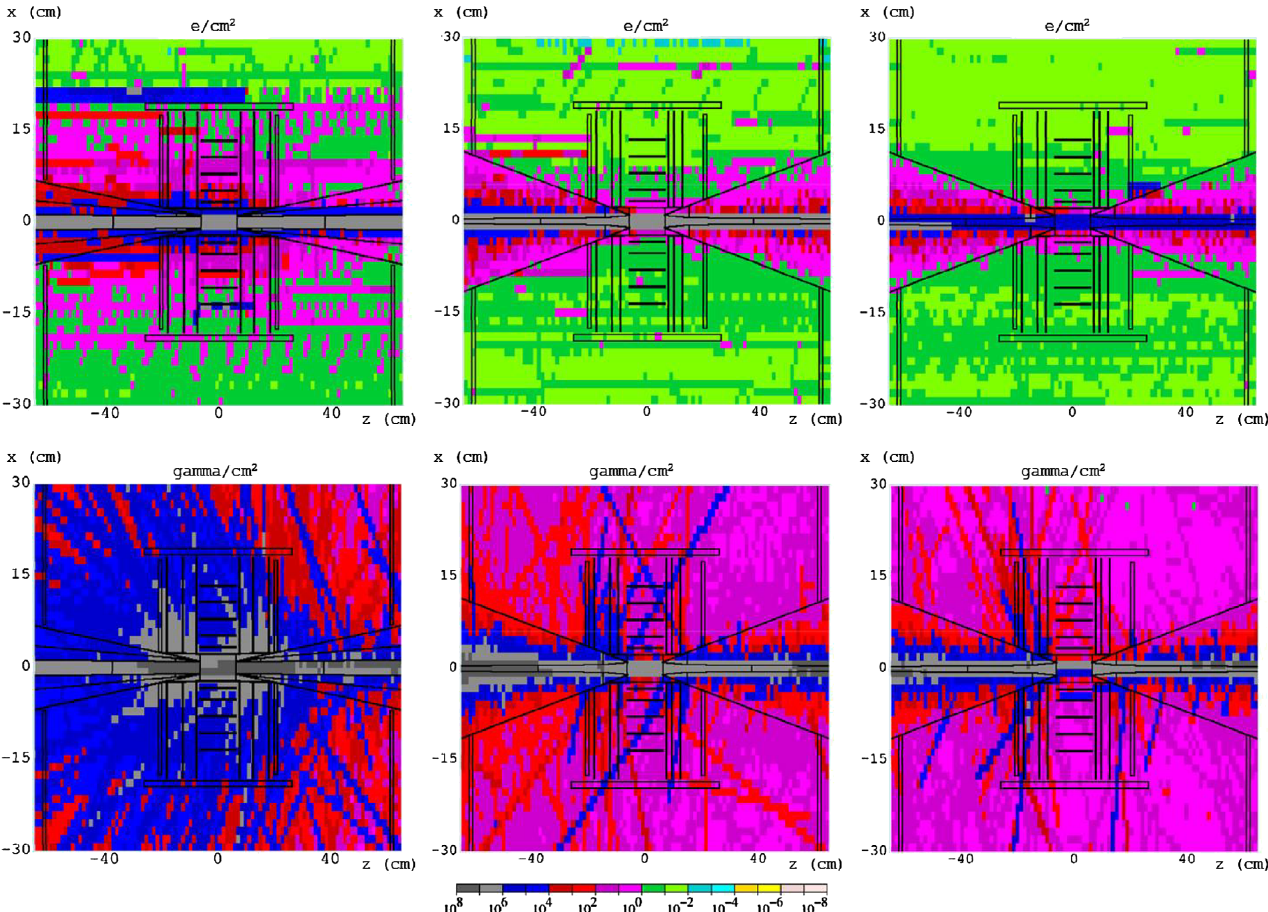
FIG. 8. Electron (top) and gamma (bottom) fluxes in the detector in three cases described in the